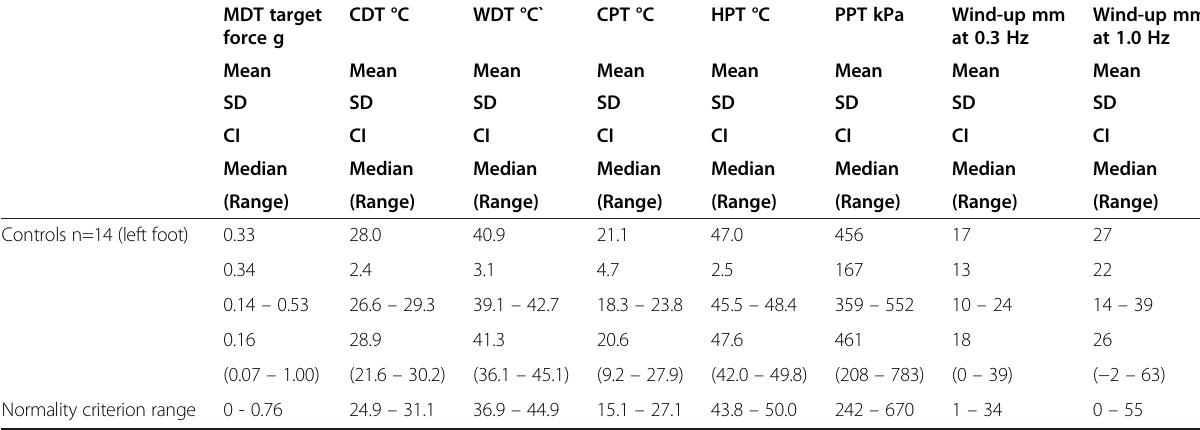
Table 5 Sensory functions in the left foot of 14 healthy controls (mean, SD, 95% CI, median and range for eight QST variables) and our calculated normality criteria (see